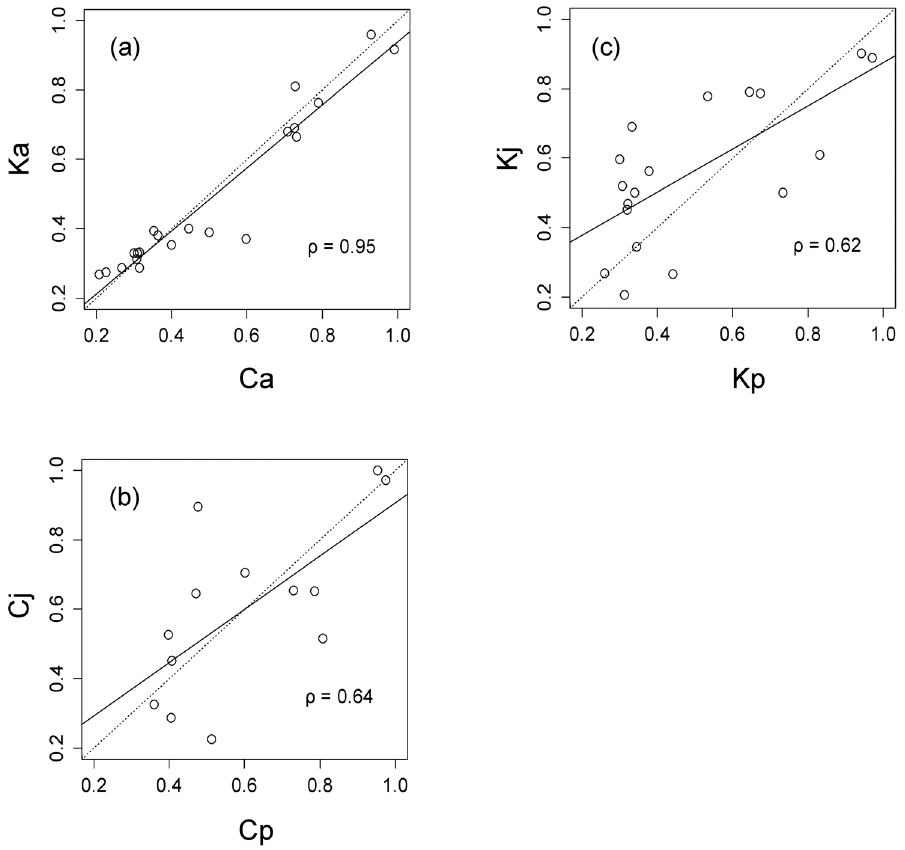
Figure 3. The correlation of significant r 2 values (fdr=0.05, r 2 . 0.2) between two sample sets and two gene pools. (a) core collection (Ca) vs plus trees in Kanto Breeding Region (Ka), (b) core collection (Pacific Ocean side (Cp) vs Japan Sea side (Cj)), c) plus trees in Kanto Breeding Region (Pacific Ocean side (Kp) vs Japan Sea side (Kj)). The solid line represents linear correlation, and the dashed line represents line of identity. r is the spearman’s correlation coefficient.